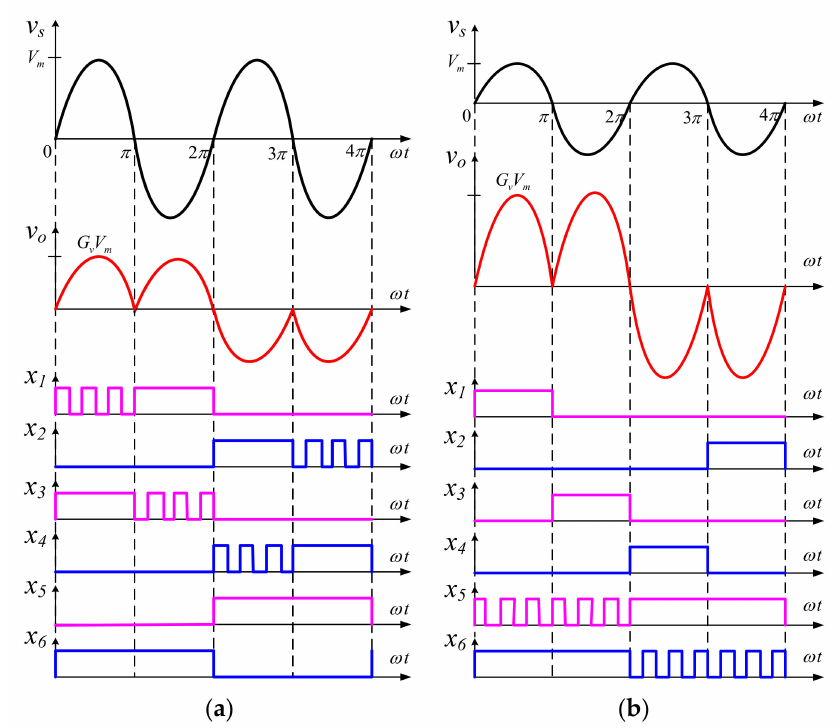
Figure 2. High and low-frequency gating signals for ( a ) voltage buck operation and ( b ) voltage boost